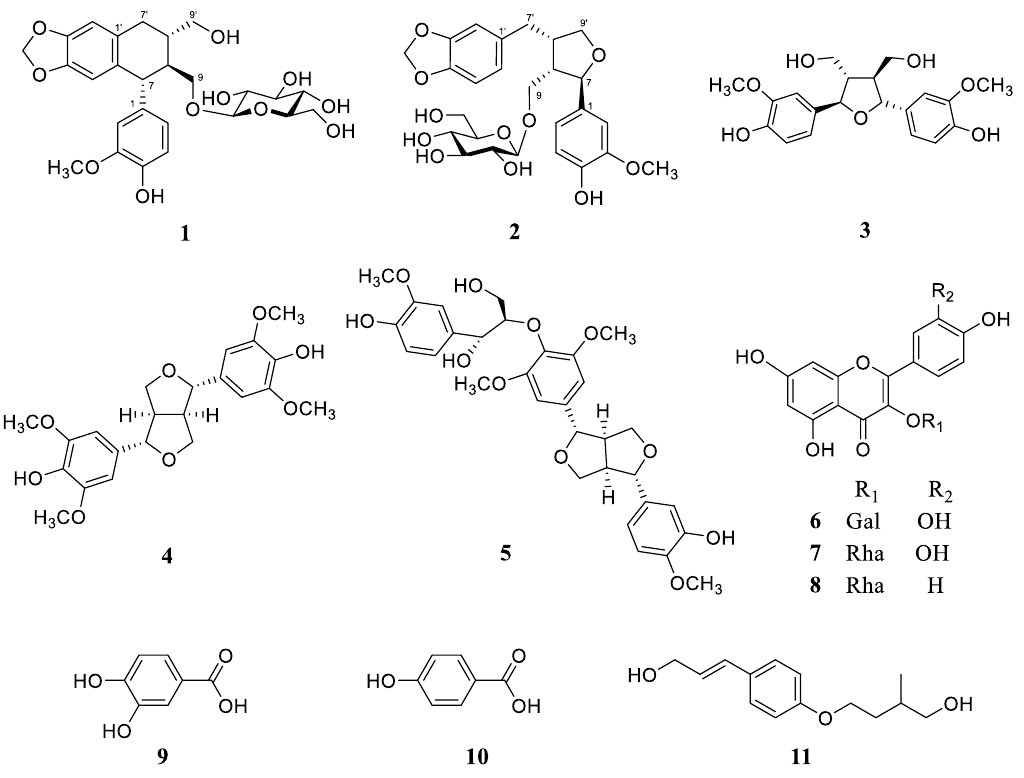
Figure 1. Structures of compounds 1 – 11 from Z. piperitum stems .